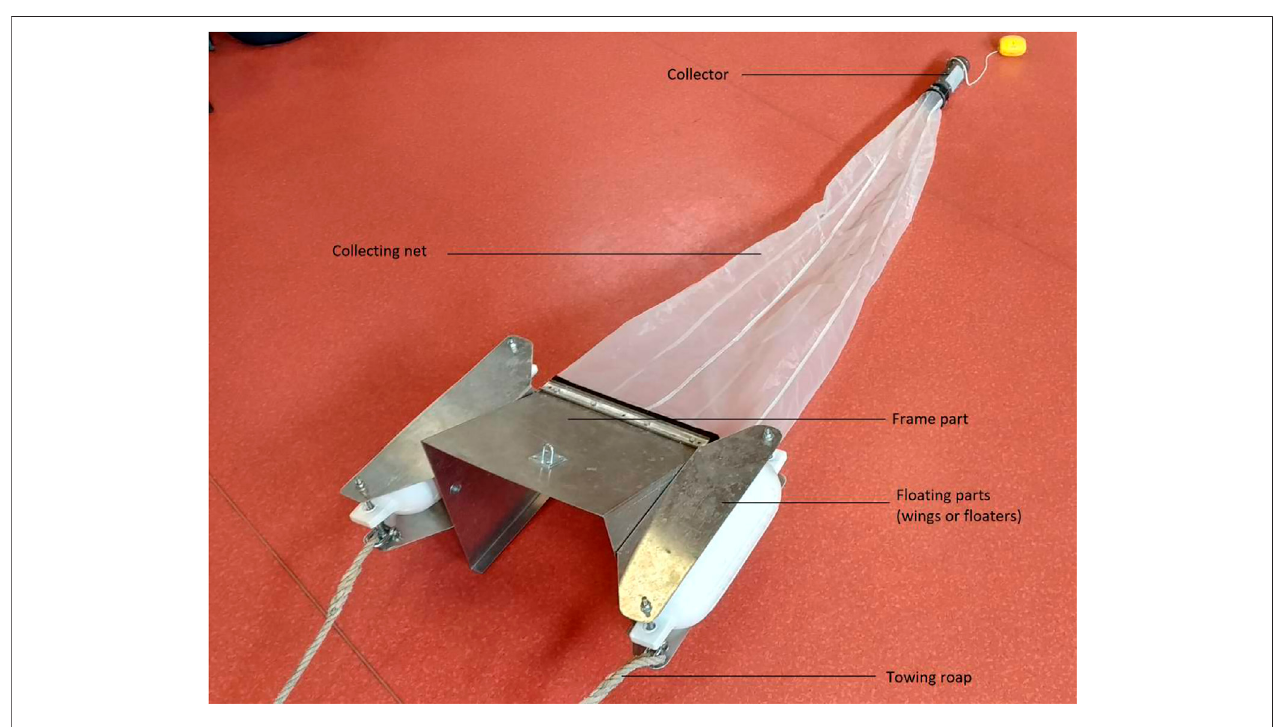
FIGURE 2 | Picture of a Manta net sampling